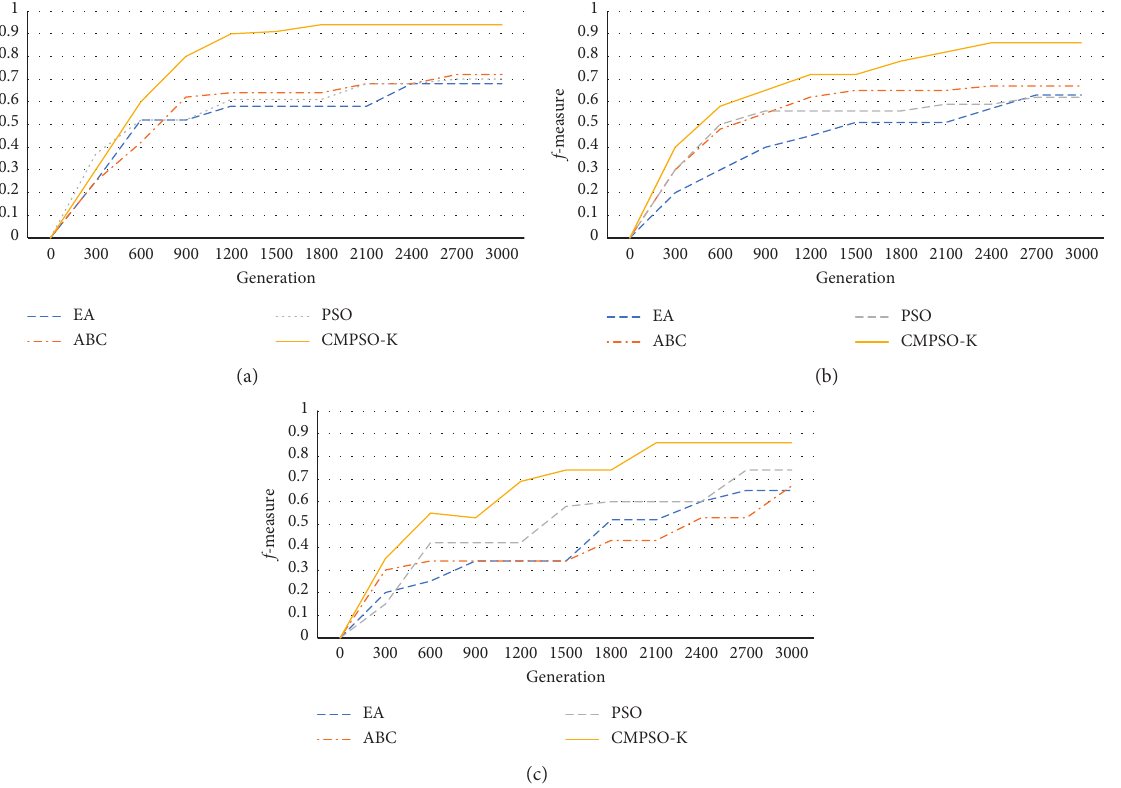
Figure 4: Comparison on the converging speed, (a) comparison on the anatomy track, (b) comparison on the large biomed track, and (c) comparison on the disease and phenotype